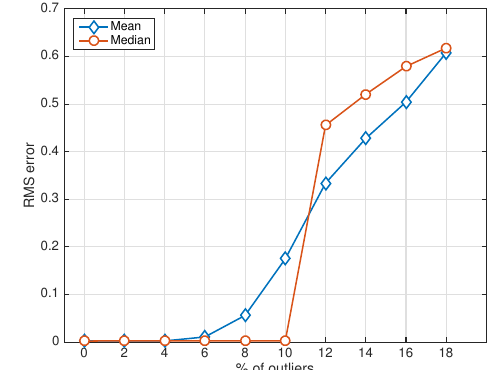
Figure 3. Failure rate of AGPA as a function of camera dis- tance d and number of tie-points visible in each image. Top row: Corresponding ray multiplicity values are [3 , 6 , 9] , where n = 96 . Bottom row: Corresponding total number of points are [96 , 192 , 288] , where the ray multiplicity is fixed to 3. Left/right column correspond to 60 ◦ / 120 ◦ field of view, respectively.